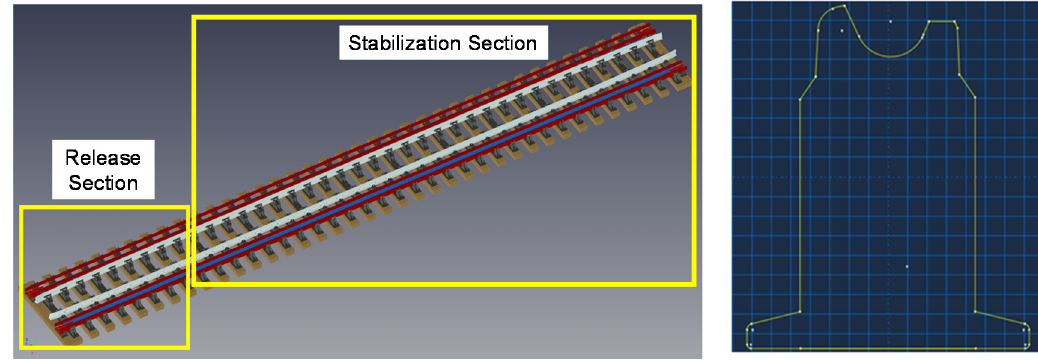
Figure 9. View of release and stabilization section and track cross-section.